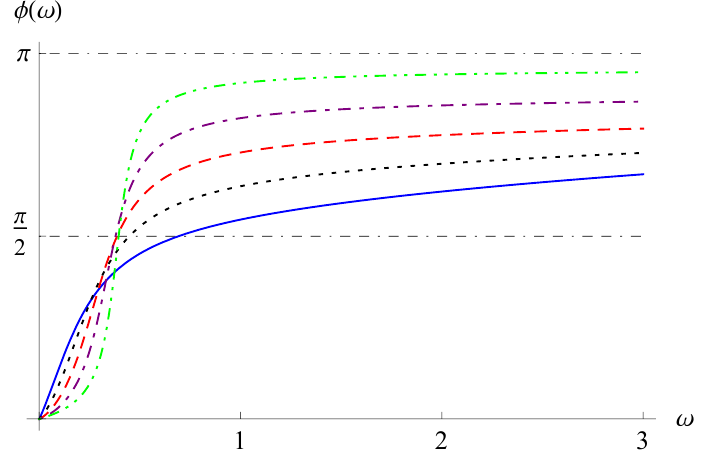
Figure 6. Frequency–phase curves for k = m = 1, c = 0.5, η = 5, and λ = 1.1 (solid line), 1.3 (dotted line), 1.5 (dashed line), 1.7 (dot-dashed line), or 1.9 (dot-dot-dashed